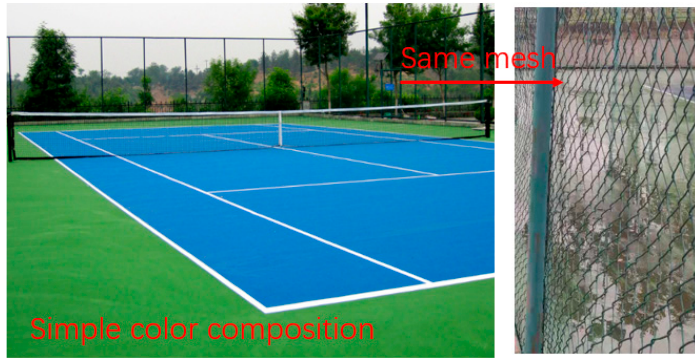
Figure 9. An illustration of the tennis court where experiment carried on.